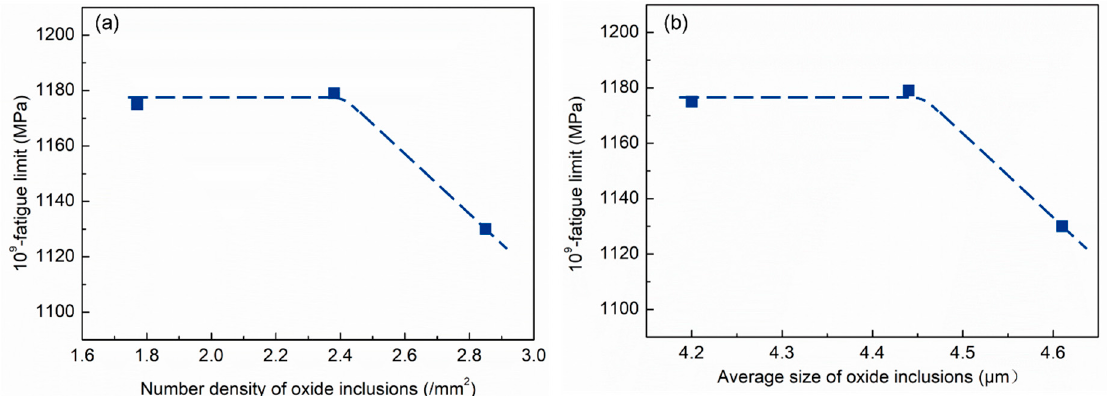
Figure 9. The correlation between the 10 9 -fatigue limit and ( a ) the number density of inclusions; ( b ) the average size of bearing steels with different cleanliness.